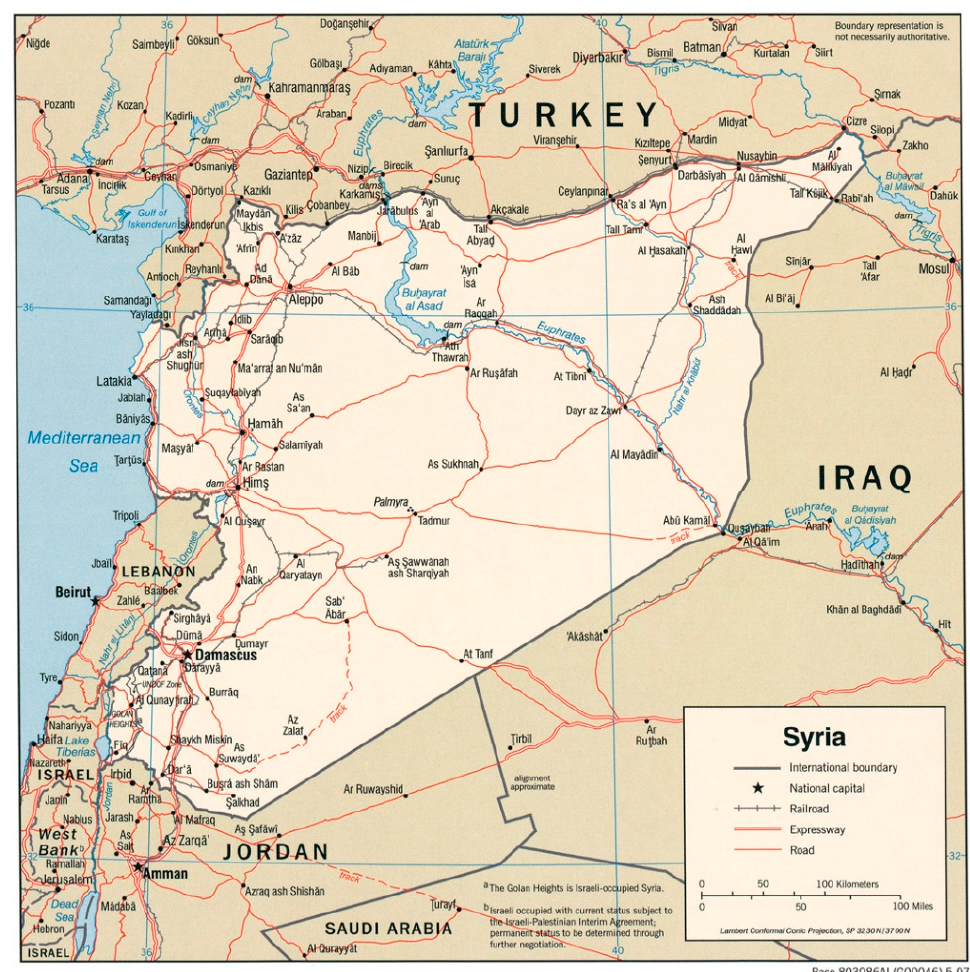
Figure 1. Map of Syria and its Neighboghrs. Source: https://maps.lib.utexas.edu/maps/middle_east_and_asia/syria_pol_2007.jpg (accessed on 4 April 2022).